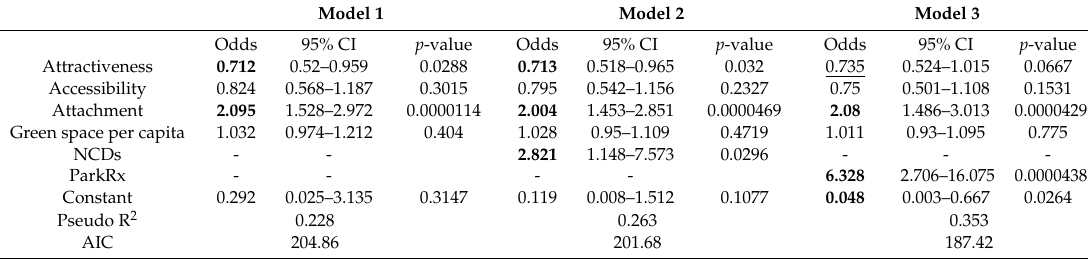
Table 5. Associations of green space characteristics, chronic disease condition, and ParkRx with use